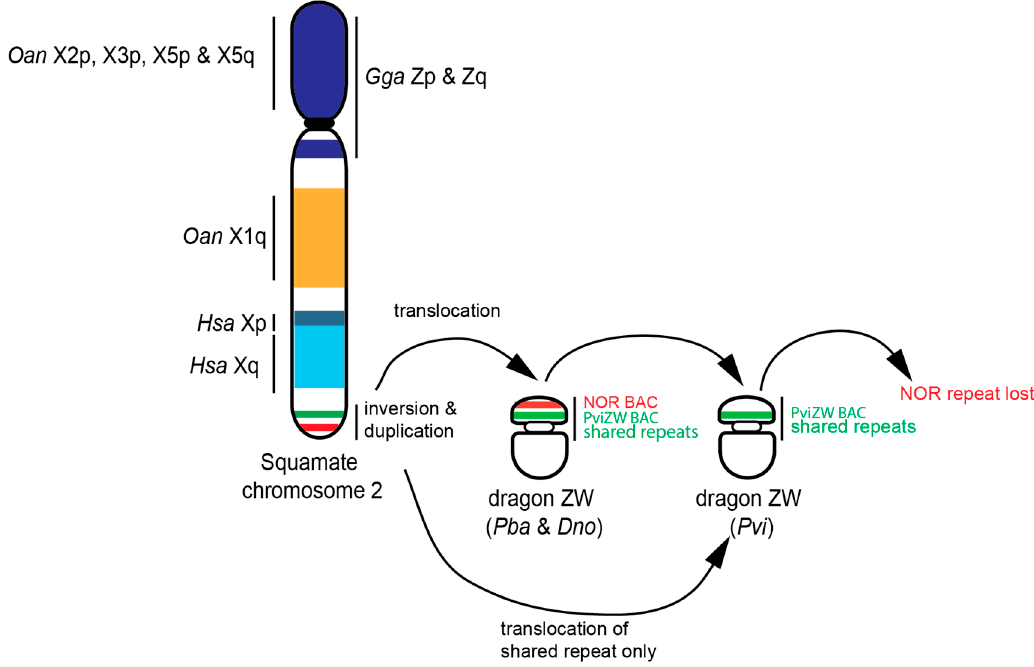
Figure 4. Schematic diagram showing hypothetical model of ZW sex chromosome evolution in Australian dragon lizards, supporting the hypothesis that squamate chromosome 2 is part of ancestral super-sex chromosomes. Gga : Gallus gallus ; Hsa : Homo sapiens ; Oan: Ornithorhynchus anatinus ; Pba : Pogona barbata , Pvi : Pogona vitticeps ; Dno : Diporiphora nobbi ; X: chromosomes; Z: Z chromosomes; W: W chromosome; p: short arm; q: long arm.